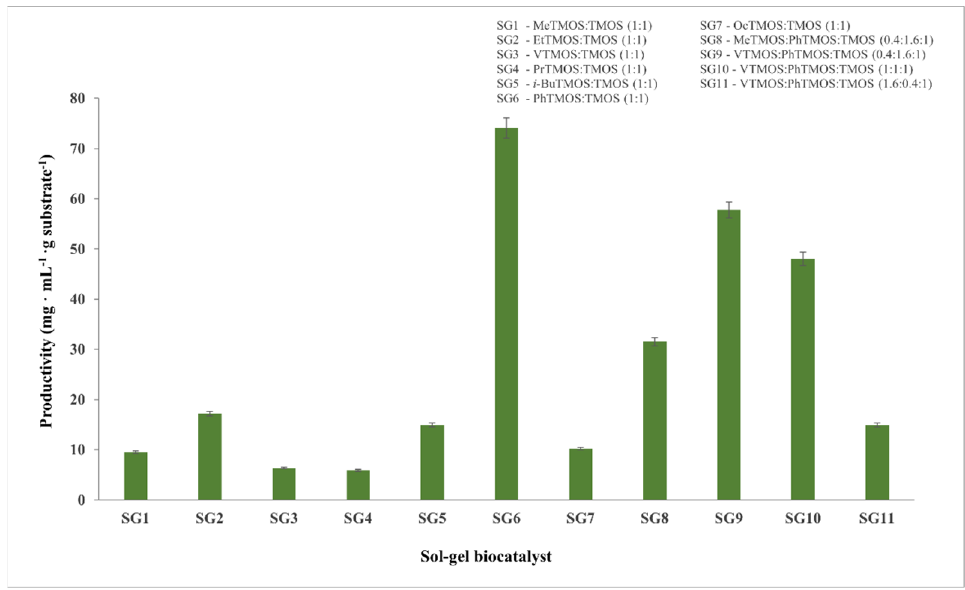
Figure 10. Enzymatic hydrolysis of microcrystalline cellulose Avicel-PH101 that was catalyzed by immobilized biocatalysts which were obtained by their entrapment in sol–gel, at 24 h reaction time and 50 ◦ C. Table 5. Influence of protein loading on the enzymatic hydrolysis of microcrystalline cellulose Avicel- PH101, at 24 h reaction time and 50 ◦ C, as catalyzed by immobilized biocatalysts which were obtained by their entrapment in sol–gel and magnetic